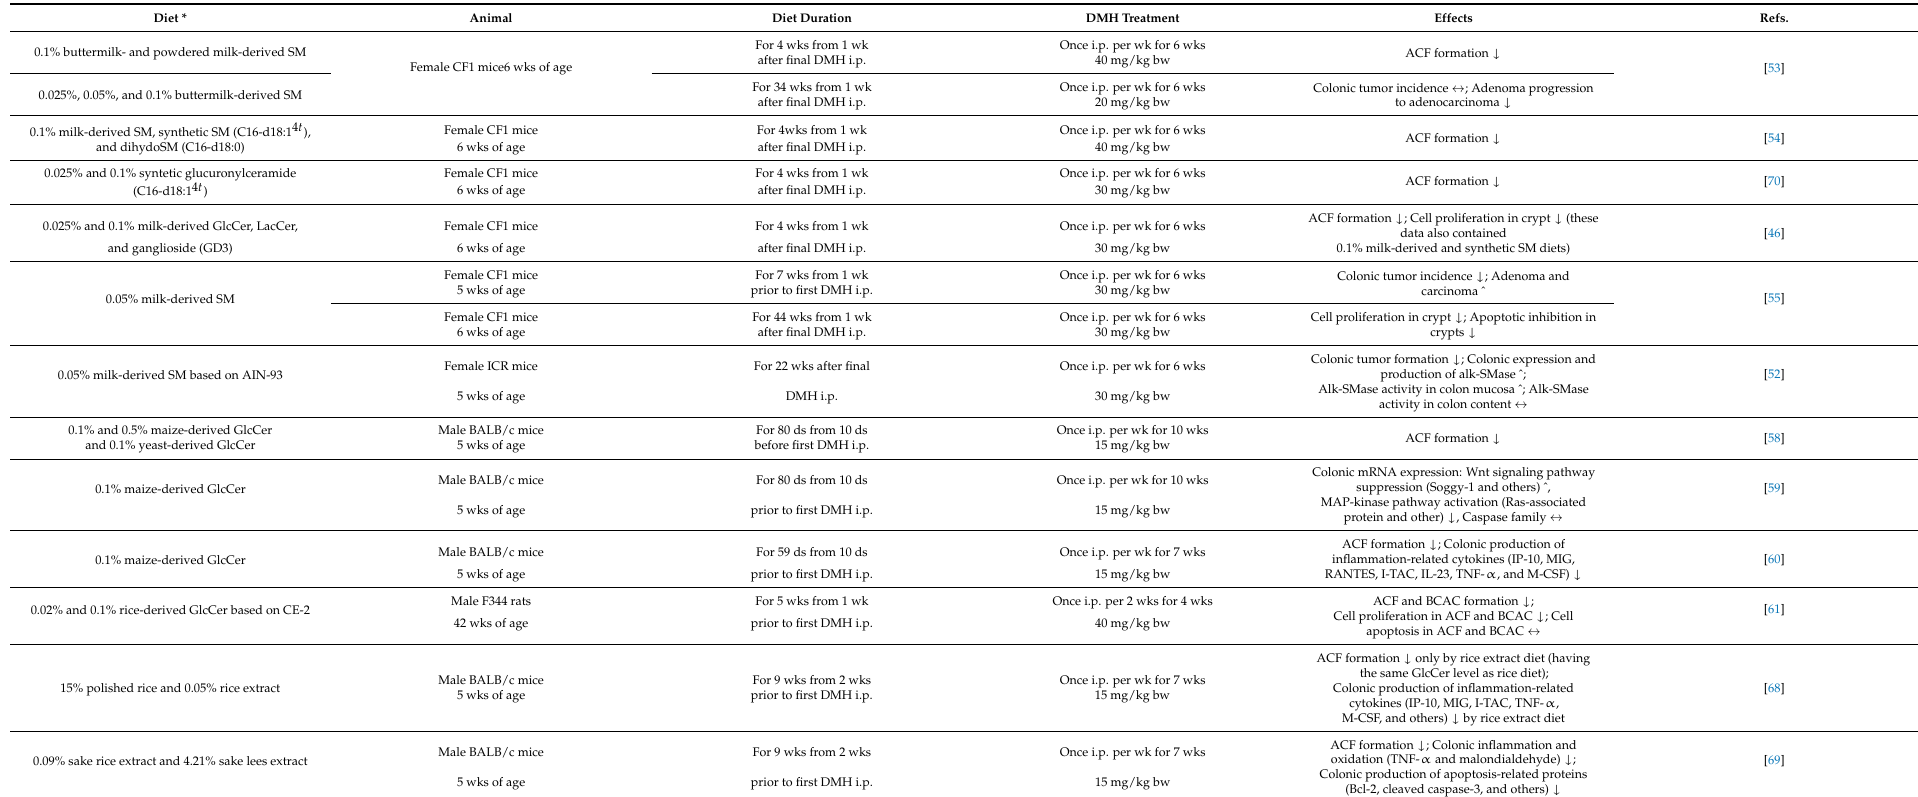
Table 3. Suppression and the mechanism of DMH-induced ACF formation by dietary